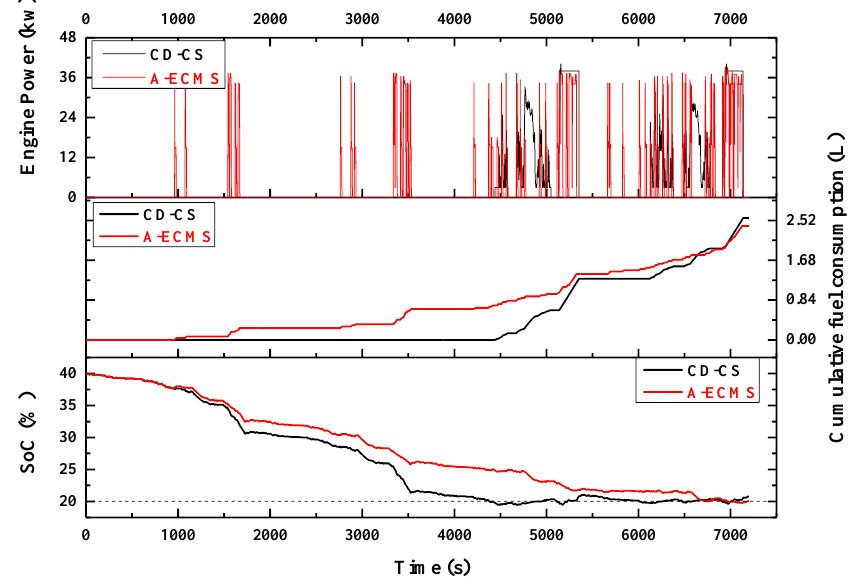
Table 5. Summary of the vehicle performance comparison for WLTC cycles.